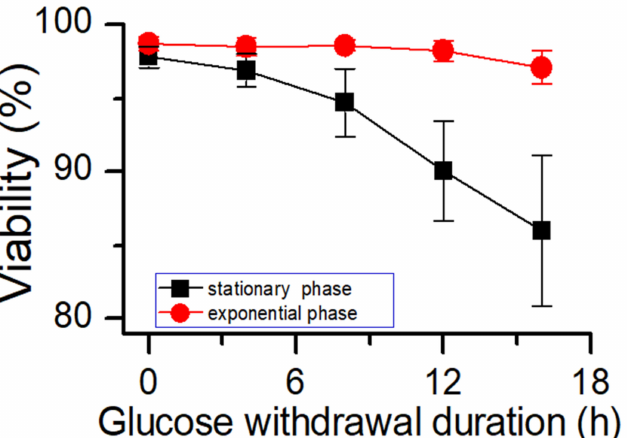
Figure 4. Effects of glucose starvation on cell viability in different culture phases. Data are expressed as mean ± standard error of three replicates.